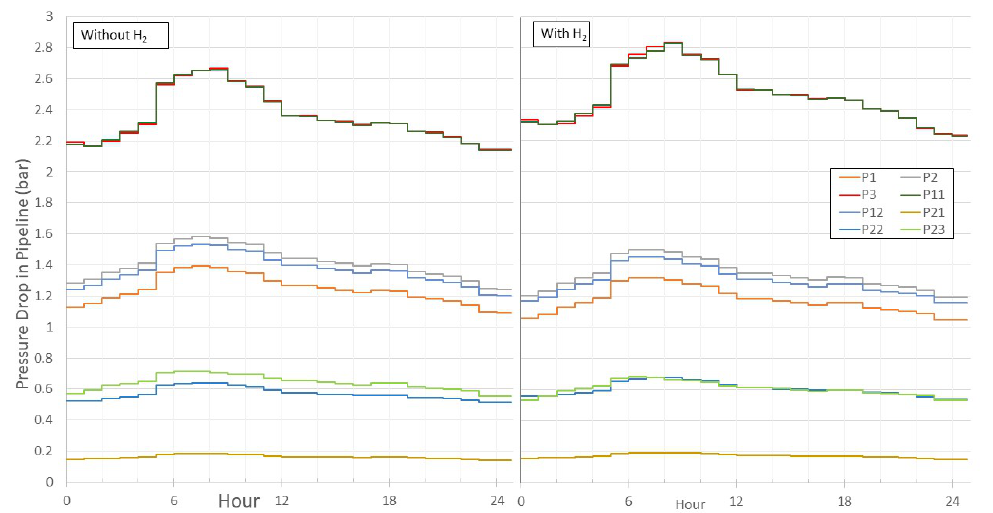
Figure 5. Pressure drop in selected pipelines (all other pressure drops < 0.5